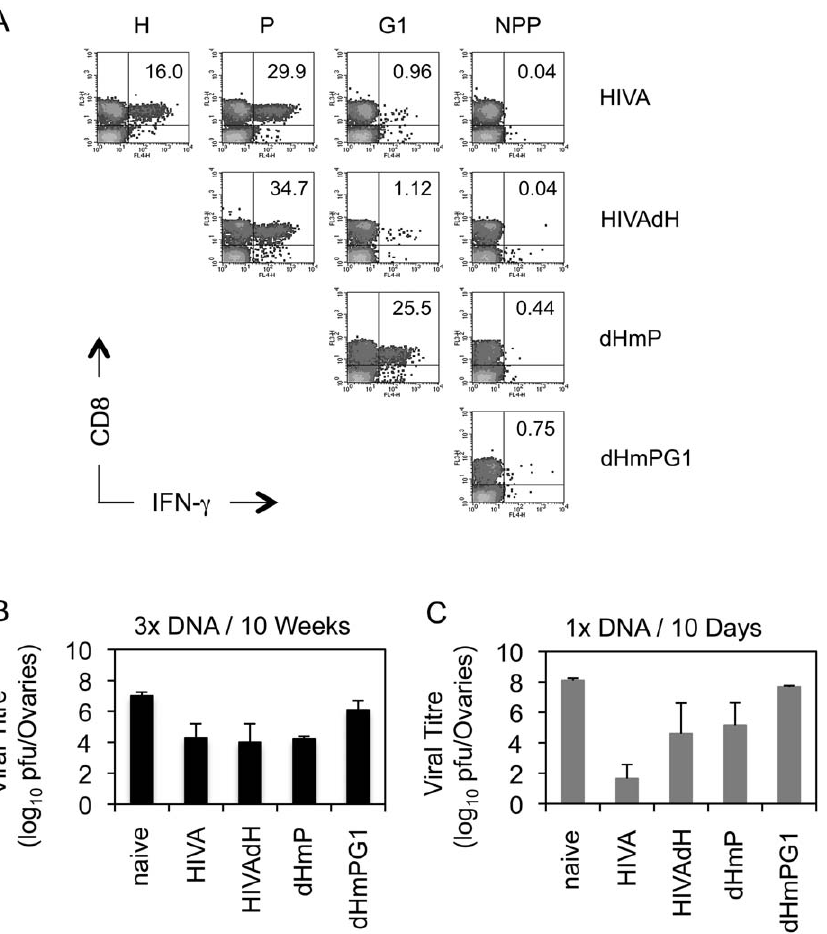
Figure 6. Recovered subdominant epitopes contribute towards protection against vaccinia virus WR.HIVA challenge. A) Groups of 4 BALB/c mice were given 3x 100 m g of DNA expressing the original and deleted forms of the HIVA immunogen at 3-wk intervals. Nine wk later, animals were bled, their PBMC pooled and their vaccine-induced CD8 + T cell responses recognizing the H, P, G1 and NPP peptides were assessed by IFN- c ICS assay. Dot plots are shown with inserted numbers indicating IFN- c producing cells as a percentage of total CD8 + splenocytes. B) Ten wk after the last vaccination, animals were challenged with 2 6 10 7 PFU of WR.HIVA i.p., sacrificed 4 d later and the challenge virus titre in ovaries was determined. C) Groups of 3 BALB/c mice were given 1x 100 m g of DNA and challenged with 2 6 10 7 PFU of WR.HIVA after 10 d and sacrificed 4 d later for the ovaries titre determination. Results in B and C are shown as mean 6 SD. Panel A is independently confirmed by Figure 5, and panels B and C show one of two